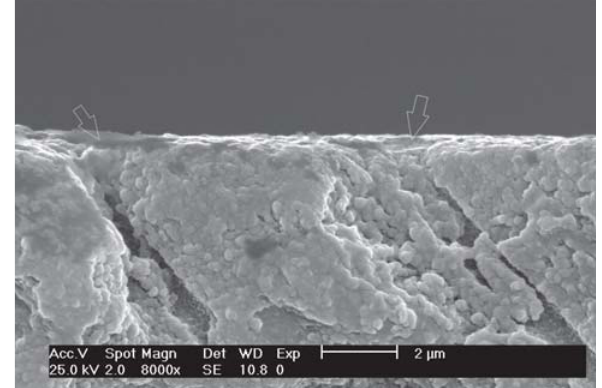
FIGURE 2- SEM micrograph of group 1 (no treatment) - Occlusal view of dentinal tubules. Observe the dentin surface completely covered by debris (smear layer) and occluded tubule openings (arrows) (x8,000)